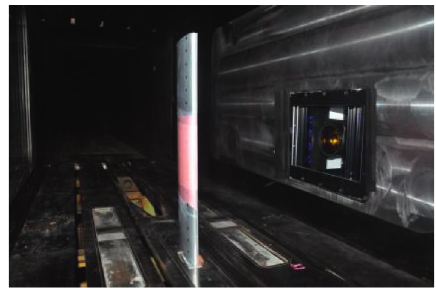
Figure 8: Model position in the test